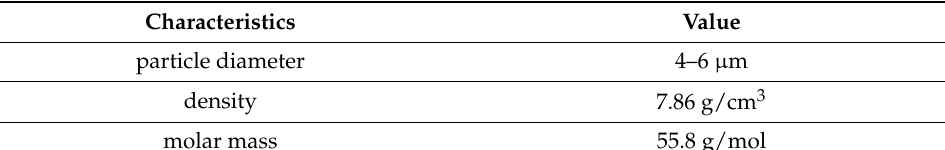
Table 1. Characteristics of the Fe particle.